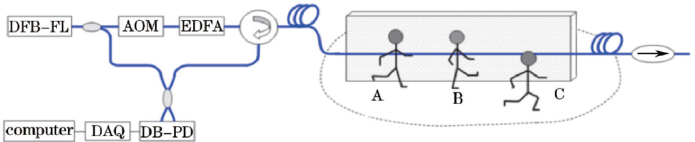
Figure 18. System scheme for intrusion detection with optical fiber fence. A-heeling; B-toeing; C-running. Reproduced with permission from our previous paper [84].